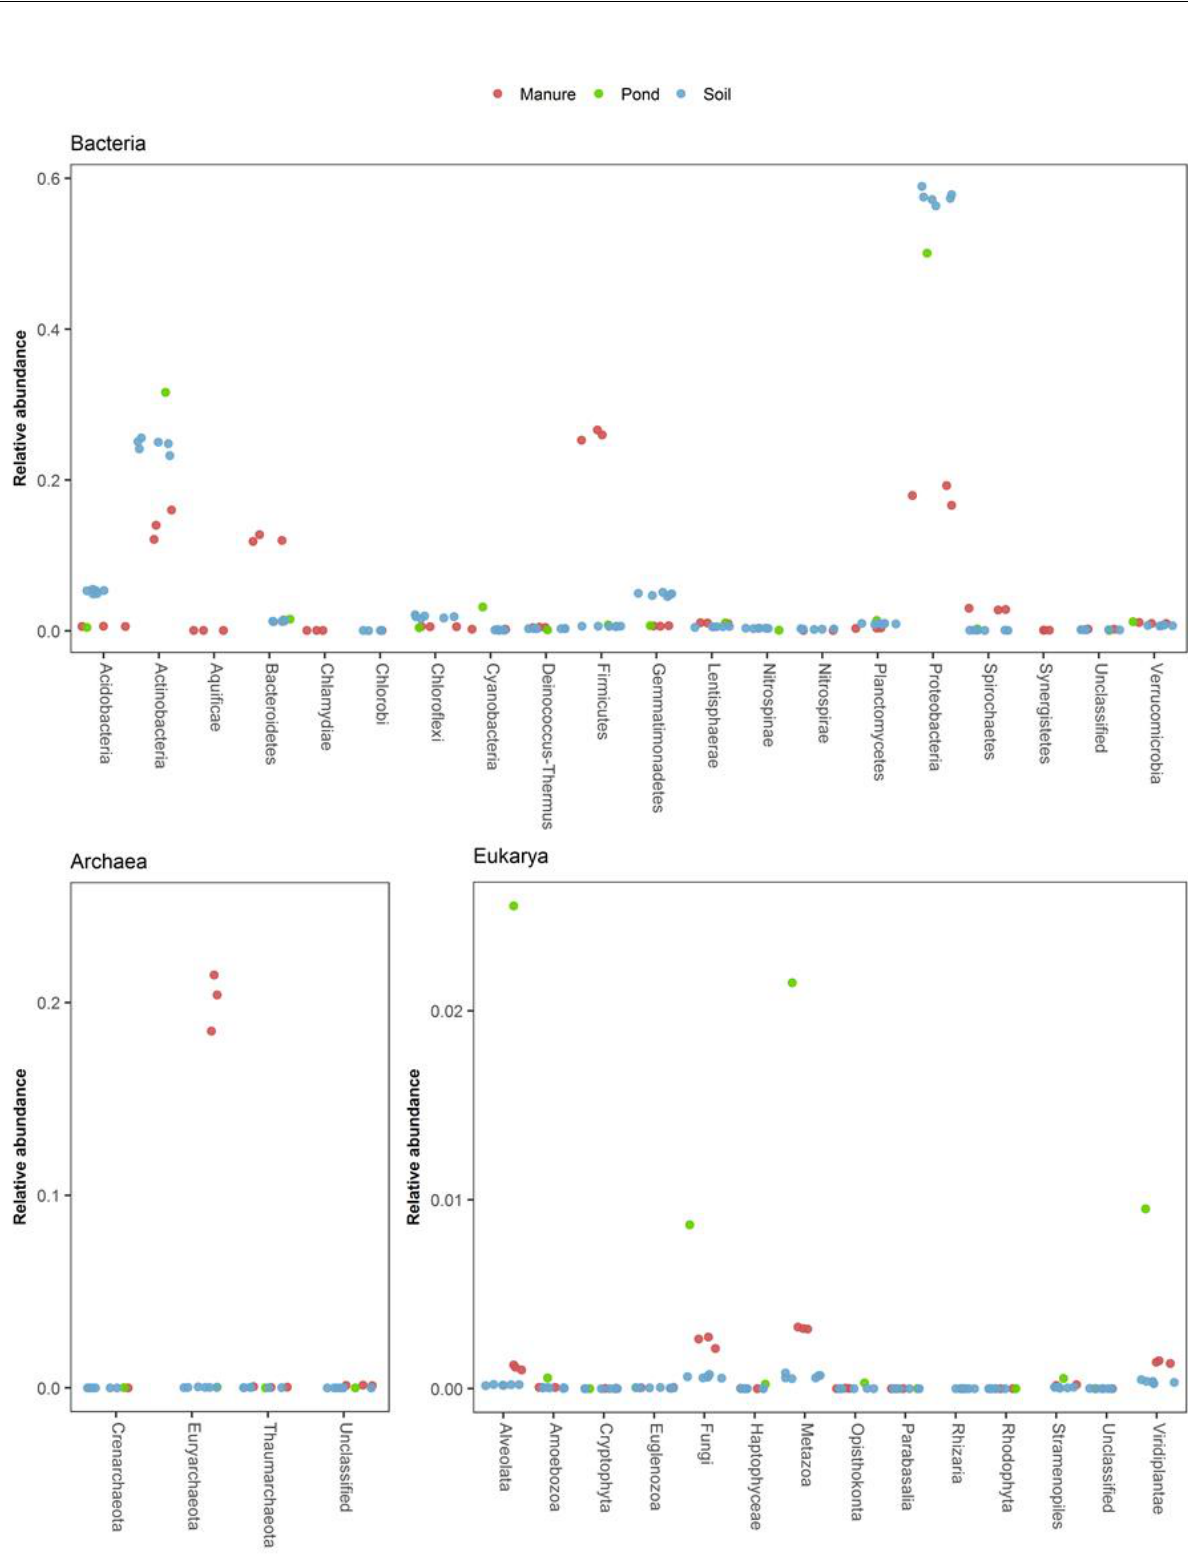
Figure 2. CaptureSeq results obtained by reference mapping on an ecologically diverse range of samples including soil ( n = 6); manure storage tanks ( n = 3); and a freshwater pond ( n = 1). The relative abundances of individual phyla are expressed as a proportion of the entire pan-domain microbial communities.